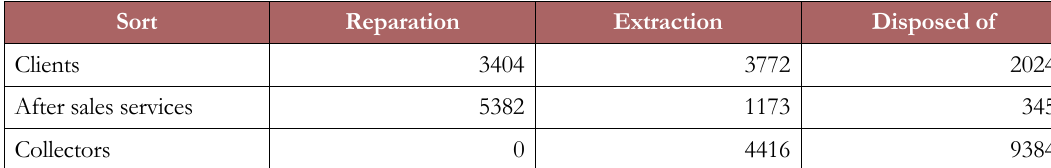
Table 3. Values of each returned product’s states depending on the